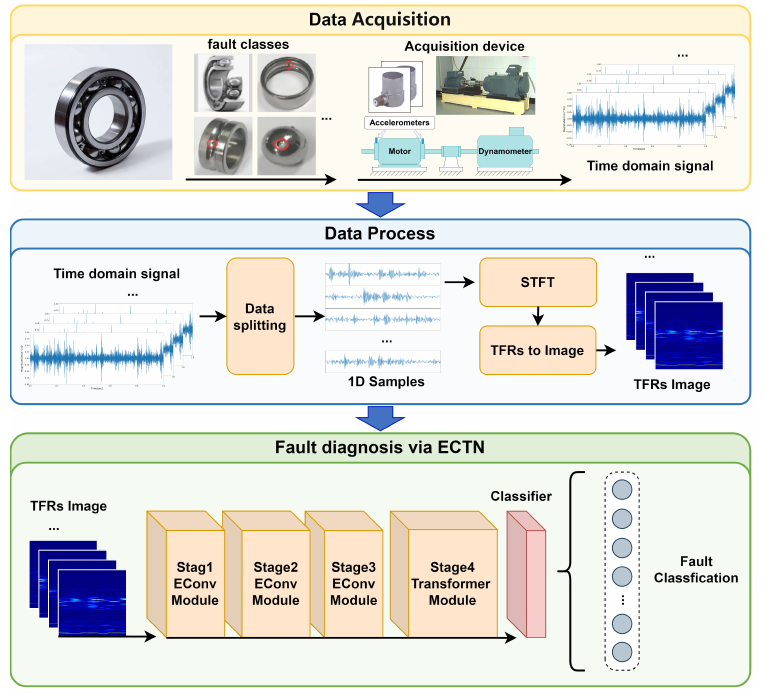
Figure 4. The framework of the proposed